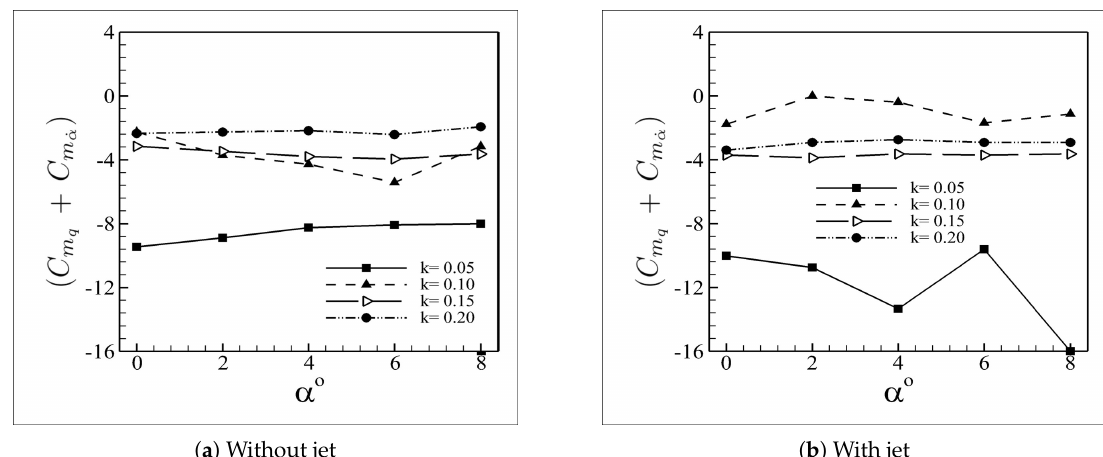
Figure 15. Effects of reduced frequency on the pitch damping of airfoil with constant α o = 0 ◦ and α A = 4 ◦